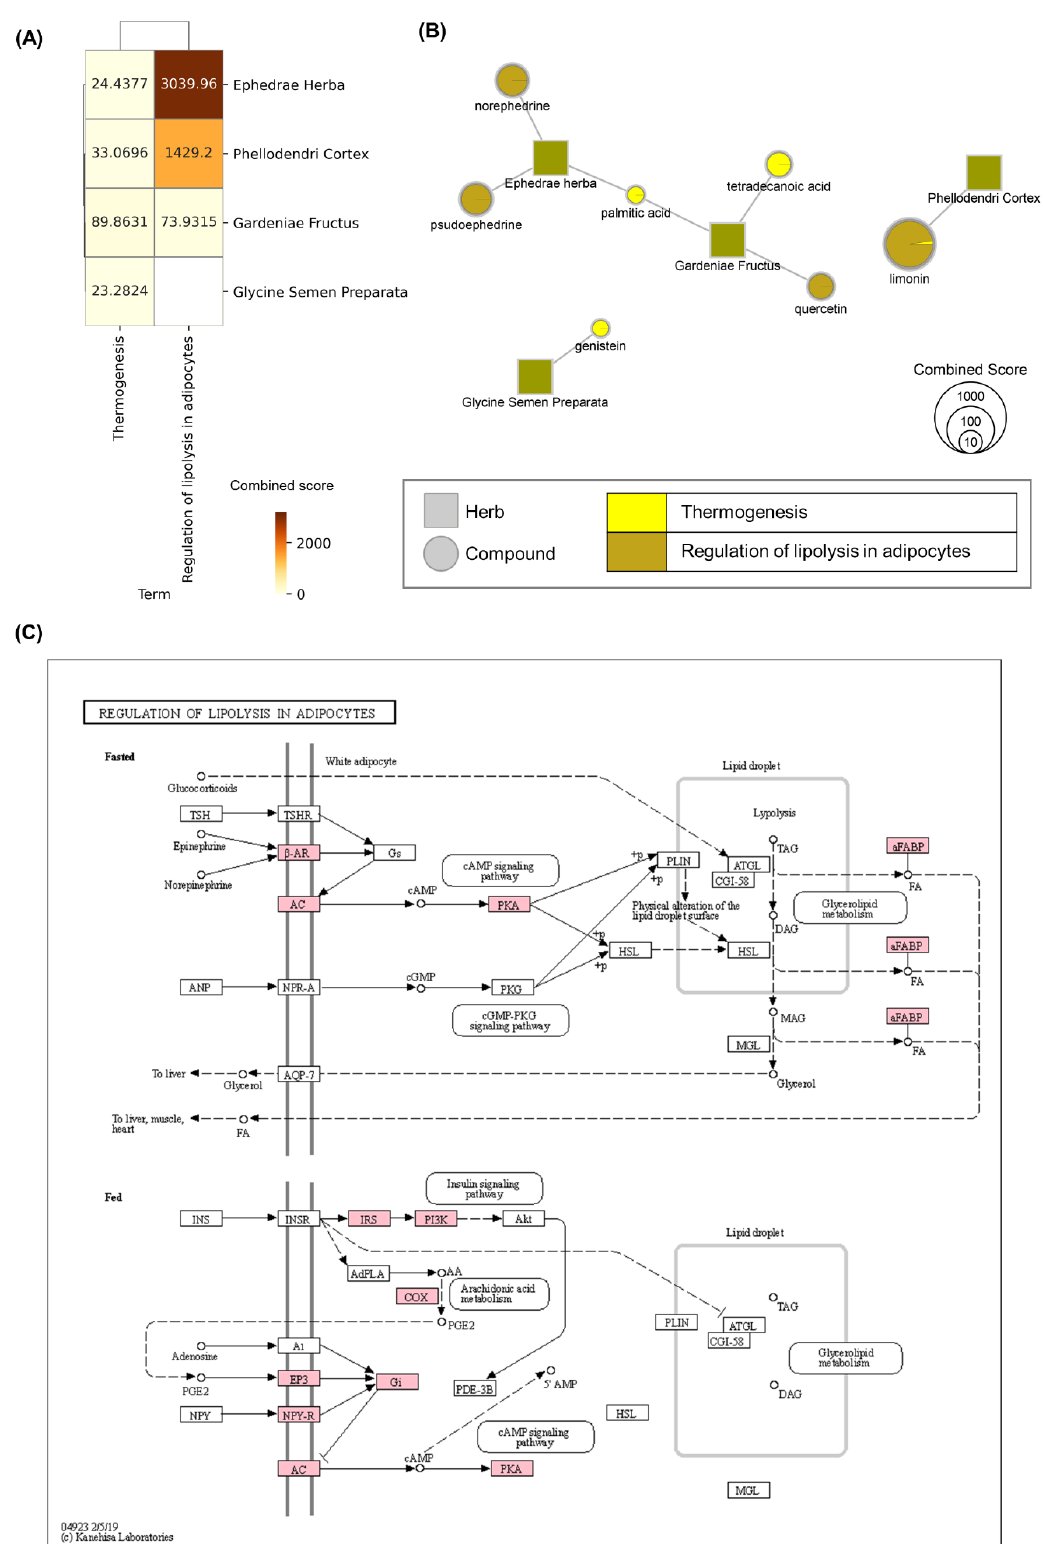
Figure 2. Association between herbs in AMGB and pathways related to lipolysis. ( A ) Cluster heatmap of combined scores of herbs. ( B ) Herb – compound network of AMGB, focusing on the association between compounds and pathways. ( C ) Pathway for regulation of lipolysis in adipocytes and predicted targets of AMGB, visualized by KEGG mapper. Boxes represent proteins that compose the pathway. The pink-colored boxes represent predicted targets of AMGB. All the details are the same as in Figure